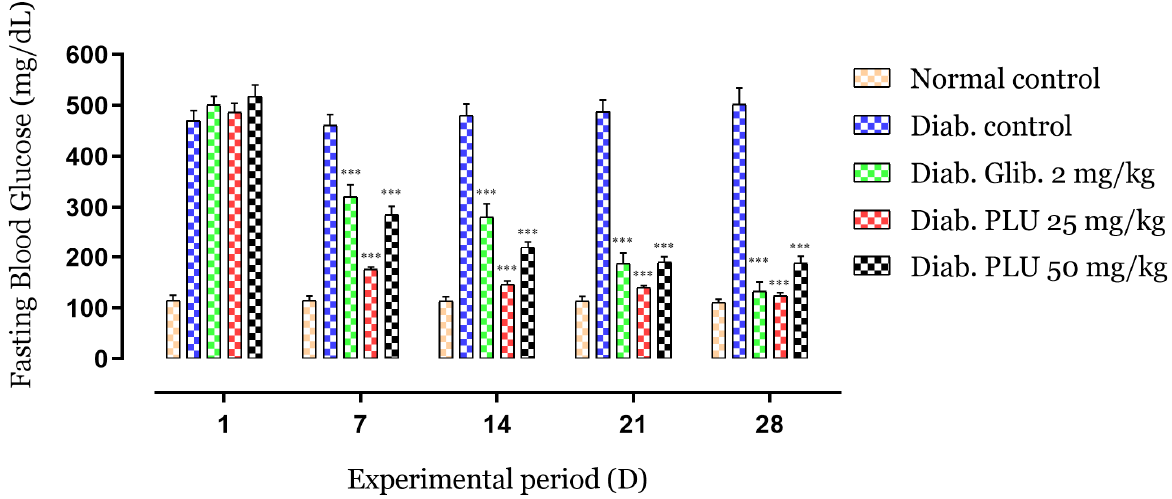
Figure 1. Effects of PLU on the FBG. Values are represented as means ± SD ( n = 5 mice). *** p < 0.001 compared to diabetic controls.